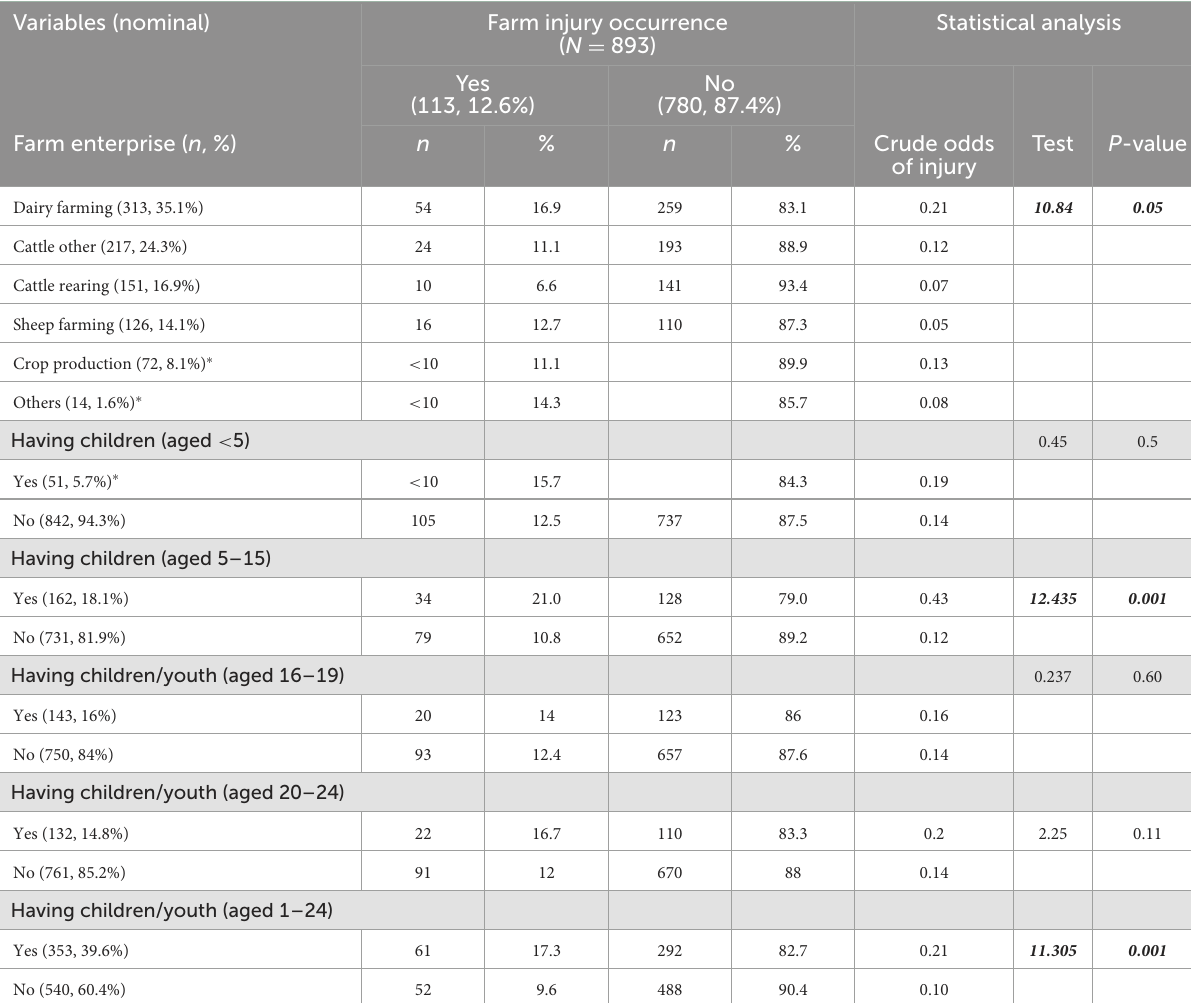
TABLE 1 Farm workplace injury occurrence associations with farming enterprise and presence/absence of children/youth by age range in farm households. Variables (nominal) Farm injury occurrence